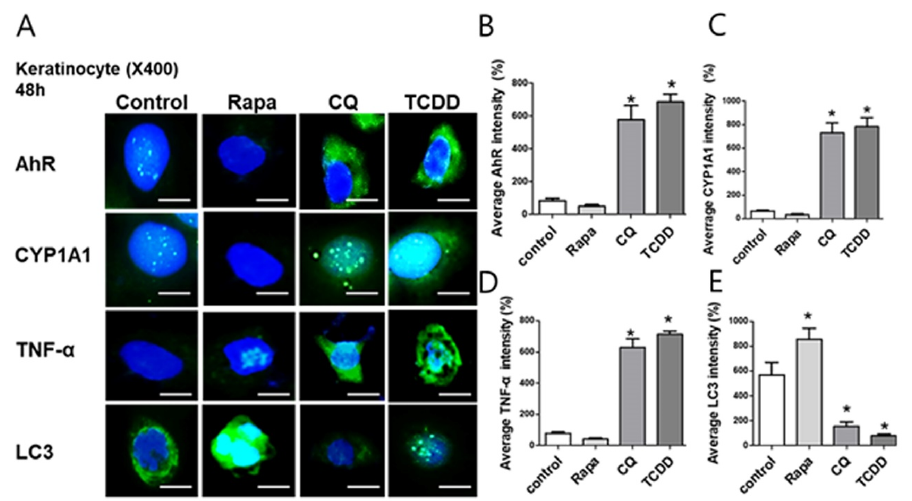
Figure 4. The effects of autophagy modulation and AhR activation on the expression of AhR, CYP1A1, TNF-α, and LC3. The level of AhR ( A,B ), CYP1A1 ( A,C ), TNF-α ( A,D ), and LC3 ( A,E ) expression was determined by immunofluorescence. Normal human epidermal keratinocytes (NHEKs) were treated with rapamycin (50 nM), CQ (20 µg/mL), and TCDD (10 nM) for 48 h. CYP1A1, TNF-α, and AhR